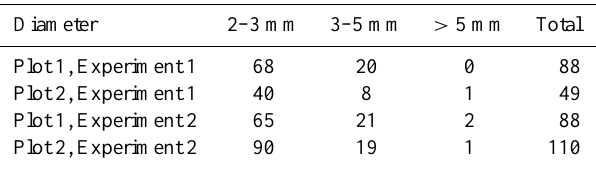
Table 3. Number of worm burrows with specific diameters ( d ) per square meter, measured at two plots for the first two experiments in a depth of